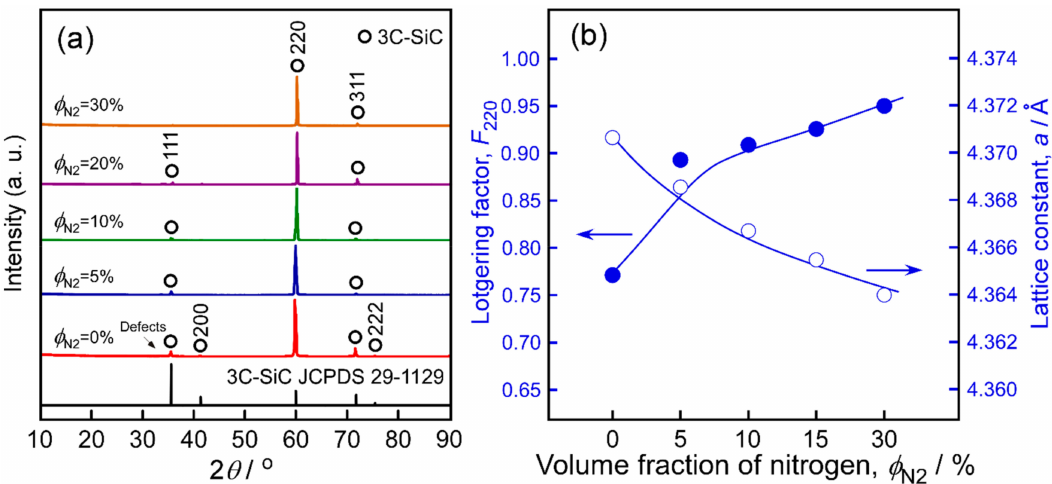
Figure 2. Crystallographic properties of N-doped 3C-SiC prepared with di ff erent φ N2 values. ( a ) XRD patterns; ( b ) Lotgering factors F 110 and corresponding lattice